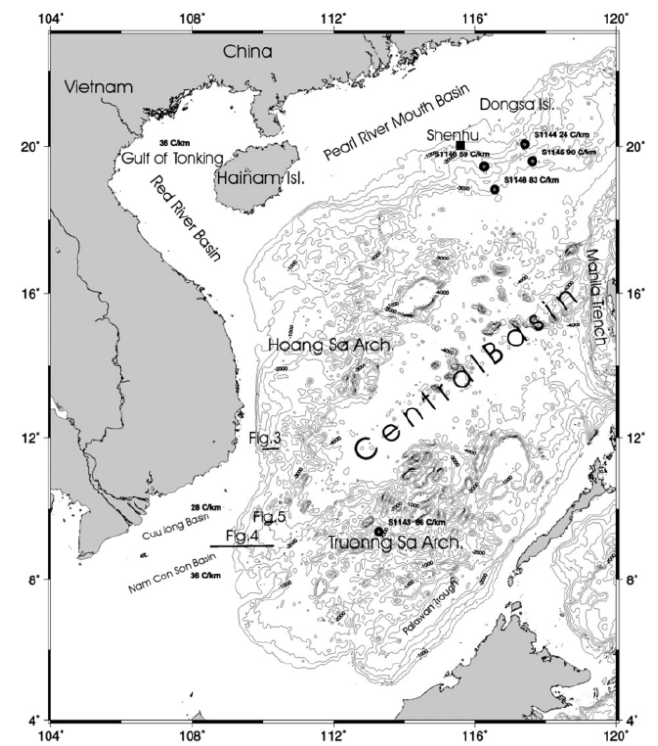
Figure 1. Map of the South China Sea